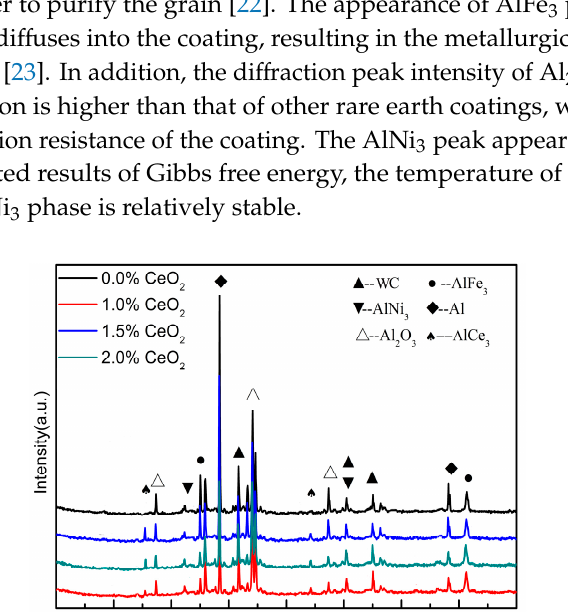
Figure 5. XRD patterns of coatings with different CeO 2 content.